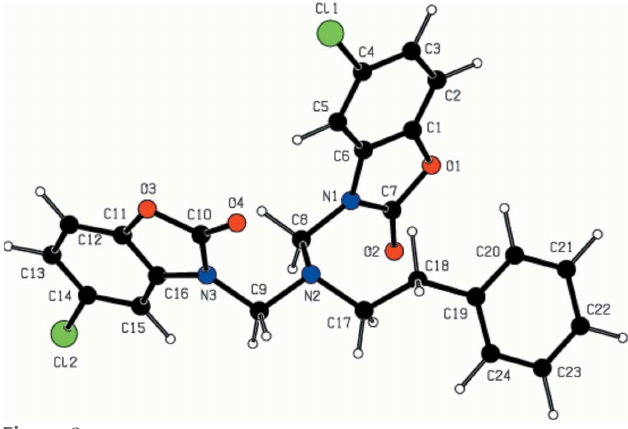
Figure 3 The molecular structure of the title compound calculated using the CNDO/2